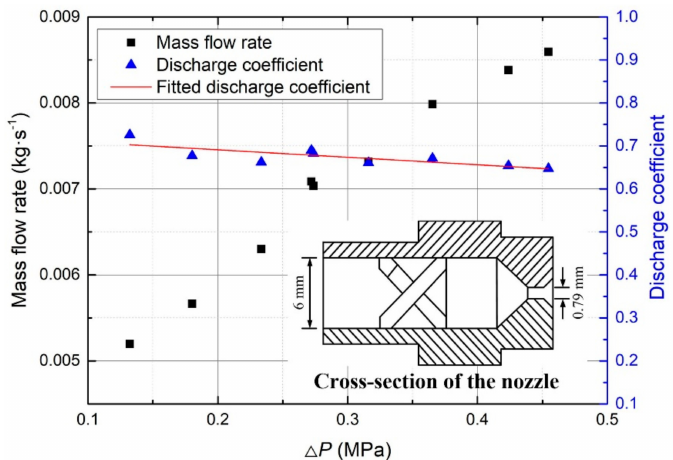
Figure 2. Mass flow rate and discharge coe ffi cient versus pressure di ff erence.